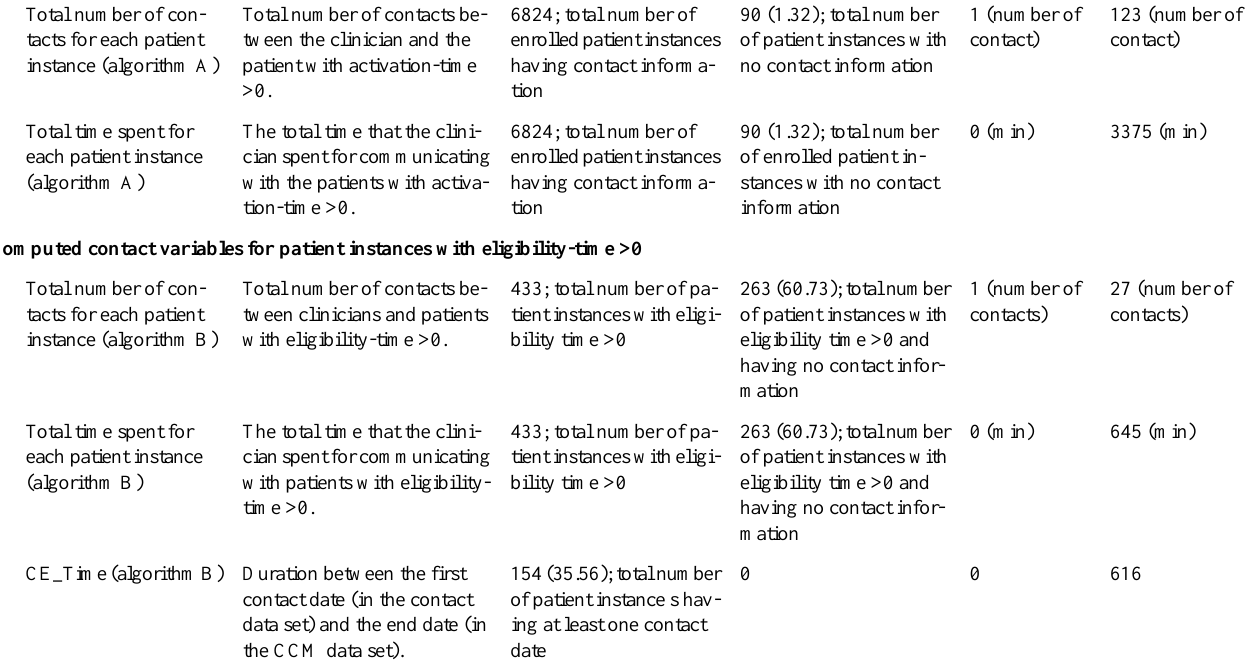
MaximumMinimumNo